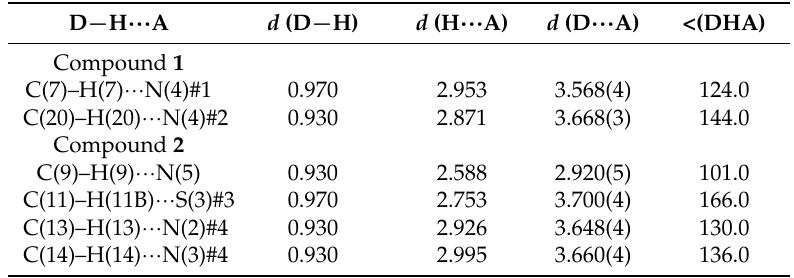
Figure 2. ( a ) A dimer formed through C–H··· π interactions between the cations (C 1 ) of 1 . ( b ) The π ··· π interactions between the cations (C 1 and C 2 ) of 1 . ( c ) The 1D chain in ···A–C 1 C 1 –A–C 1 C 1 ···sequence through C–H···N hydrogen bonds between the anions and cations (C 1 ) of 1 . ( d ) The S··· π and C–H···N interactions between the anions and cations (C 2 ) of 1 . Table 2. The parameters (Å, ° ) of hydrogen bonds in 1 and 2 .